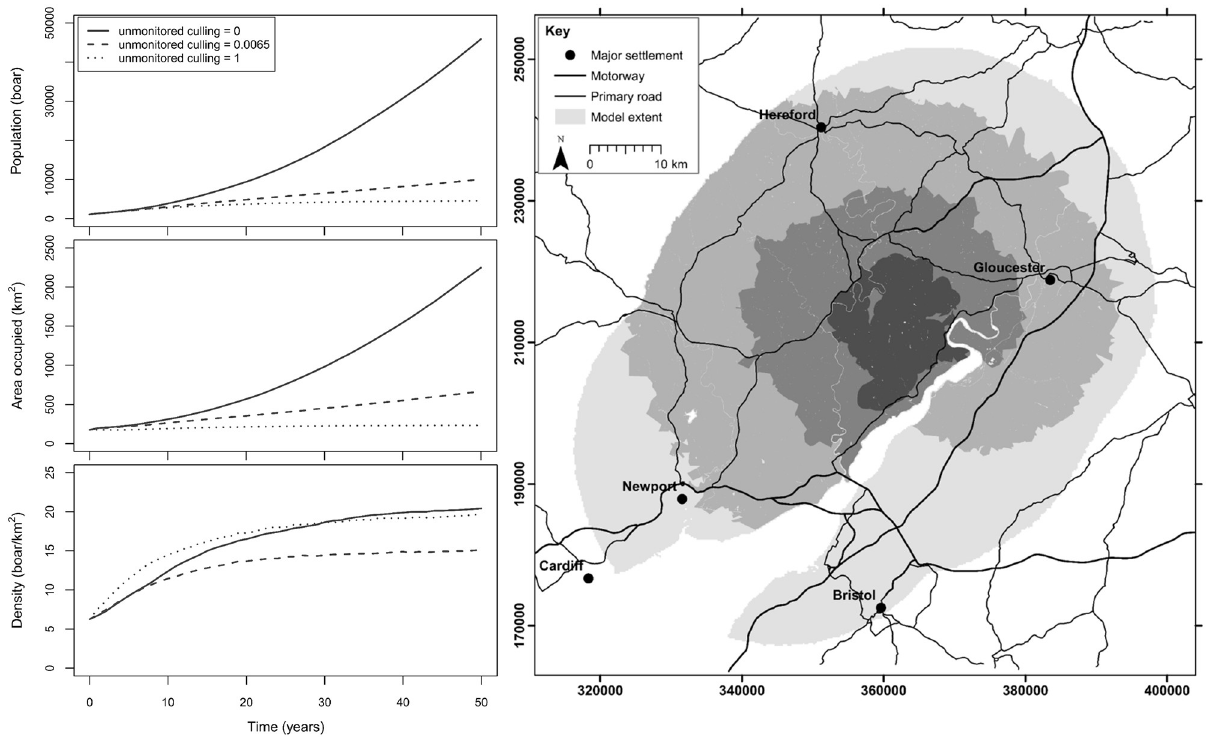
Fig 3. Population growth under various management scenarios. Time series plots (left) show: total population (top; L top ); total area occupied (middle; L mid ); mean density (bottom; L btm ); at fixed recording week, corresponding to the timing of the annual surveys conducted in the Forest of Dean, each year of the 50 year simulation period for various levels of hunting (unmonitored culling) on the private land beyond the FC estate. Map (right) shows the maximum extent of populations (boar present in at least one simulation) after 50 years of simulation under each of these management scenarios. Darker shades of grey denote increasing levels of unlicensed hunting on the area outside of the FC estate, where culling can be regulated, with the darkest shade reflecting immediate removal (unmonitored culling = 1) and the lightest (excluding region denoting model extent) reflecting no control (unmonitored culling = 0).